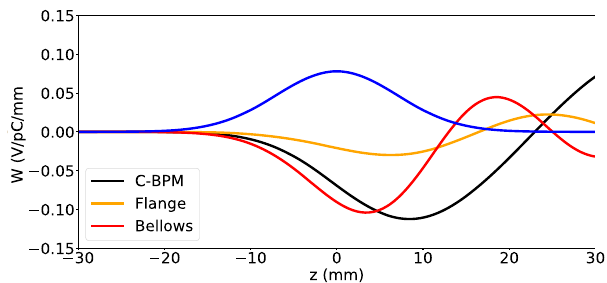
FIG. 2. Transverse wake potential W (V/pC/mm) of the ATF2 bellows (red), C-BPMs (black) and flanges (orange) calculated with G dfid L for a Gaussian bunch of 7 mm rms length and a 1 pC charge with a vertical offset of 1 mm. For reference, the distribution of the electrons in one bunch is shown (blue). The head of the bunch points towards negative z .